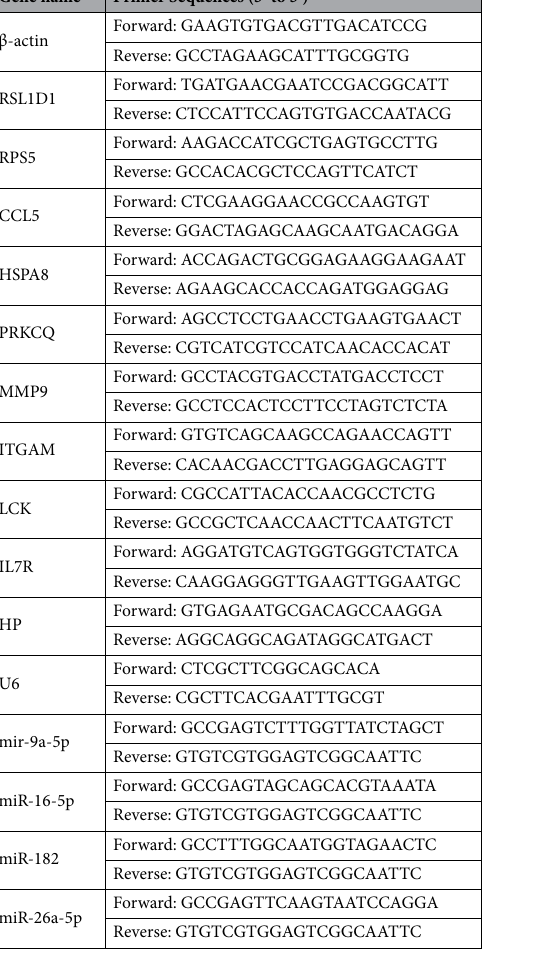
Table 2. The sequences of